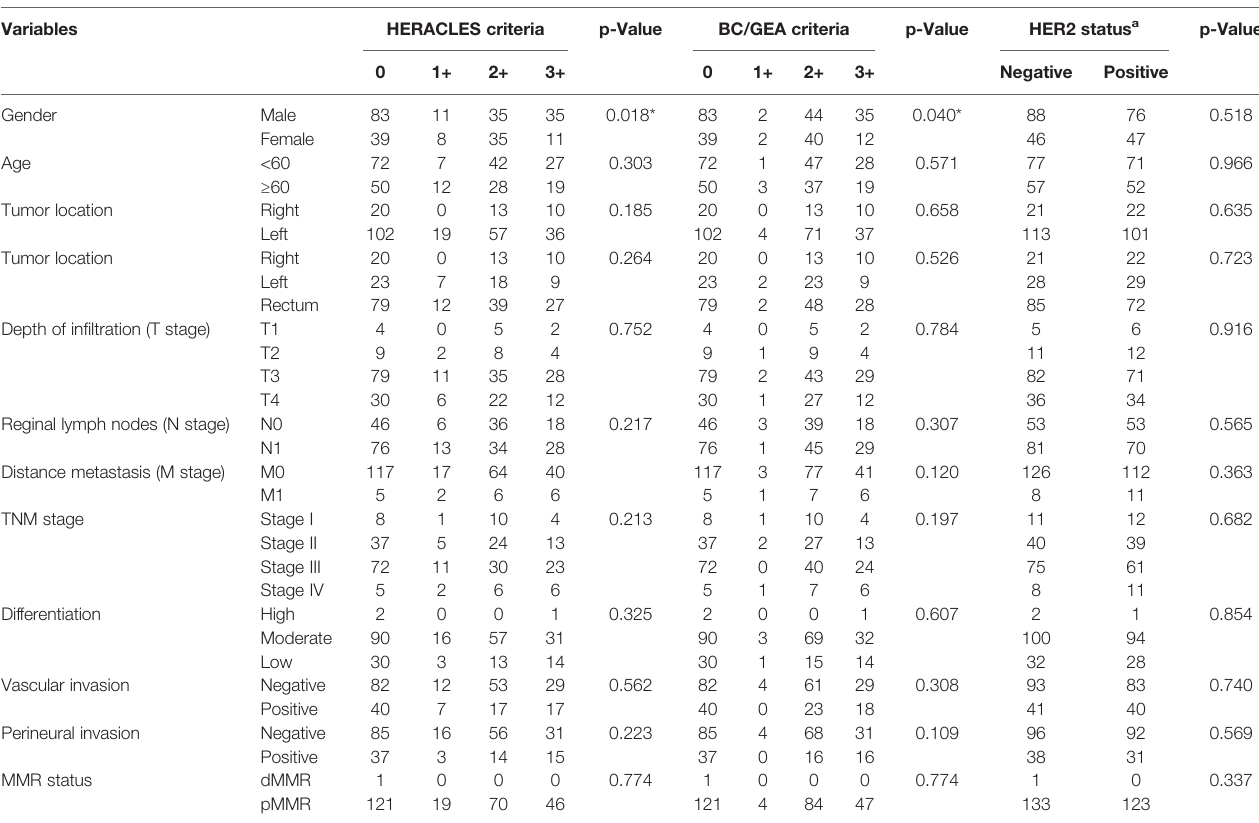
TABLE 3 | Correlation between HER2 expression and clinical parameters in the matched group (n = 257). Variables HERACLES